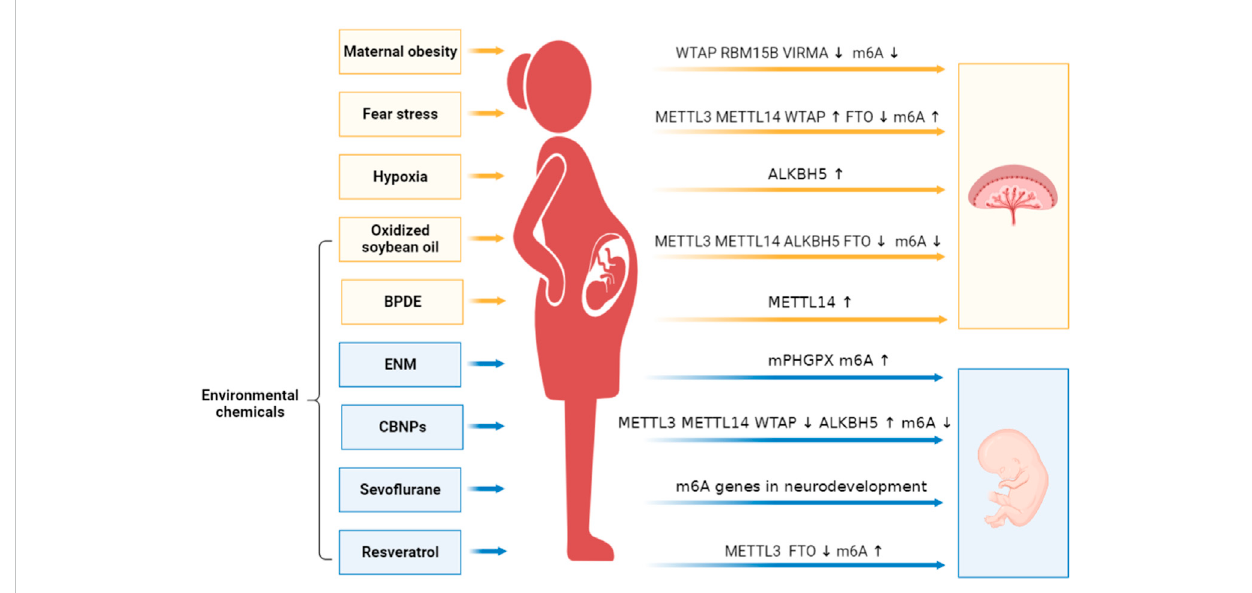
FIGURE 2 RNA m 6 A act as sensitive effectors and regulators in maternal-fetal crosstalk. Several environmental factors act on the mothers, and affect the m 6 A modi fi cations in placentas (orange) and fetal tissues (blue). Alterations of m 6 A modi fi cations regulate the expression of hub genes and disturb the placental and fetal development. This fi gure was drawn using BioRender